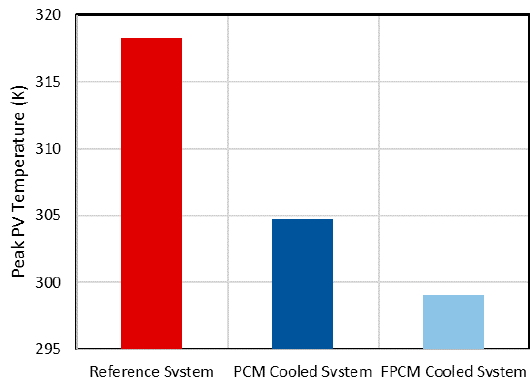
Figure 3. Peak temperature attained by PV panel of reference system, PCM cooled system and FPCM cooled system.